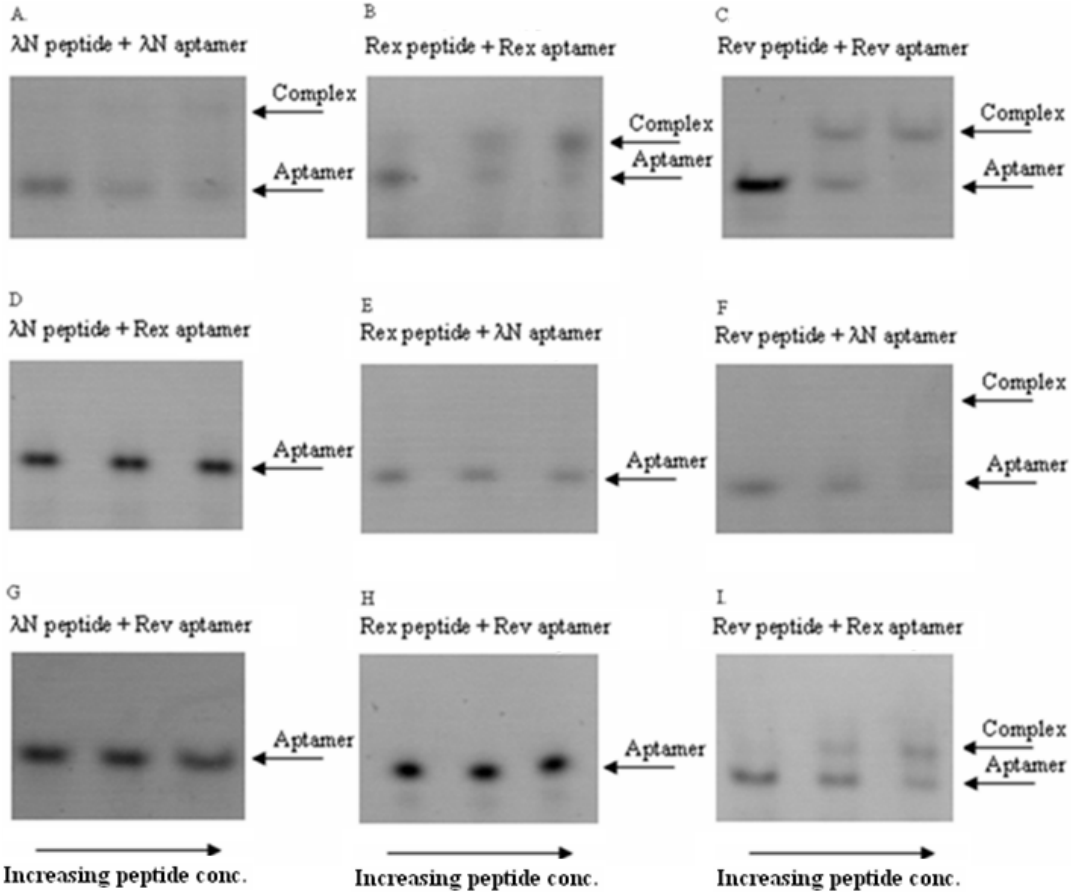
Figure 2. Cross-reactivity of three pairs of peptide/RNA aptamers. In these titration experiments, the variable amounts of viral peptides were in excess over fixed amounts of RNA aptamers (~20 nmole).